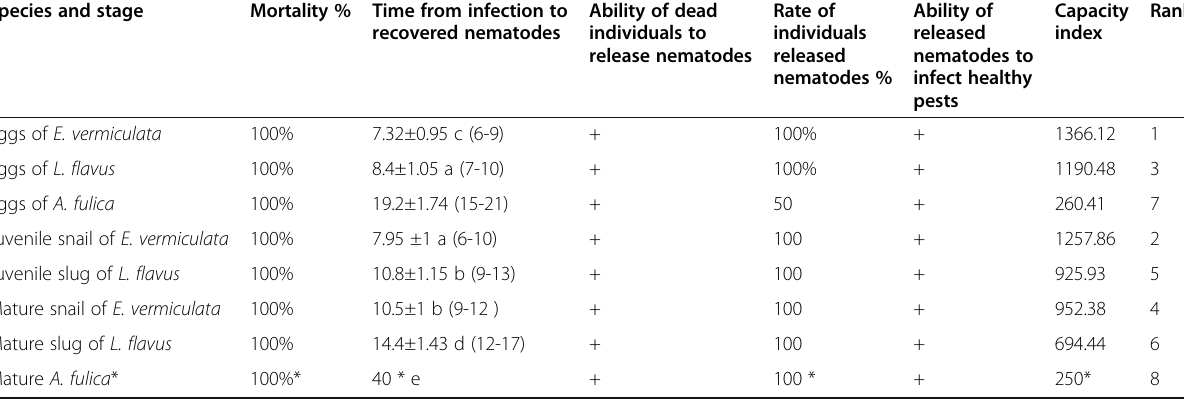
Table 1 Capability of Phasmarhabditis sp. to infect different species and stages of terrestrial gastropods under laboratory conditions of 22±2 °C and 60±5R.H.